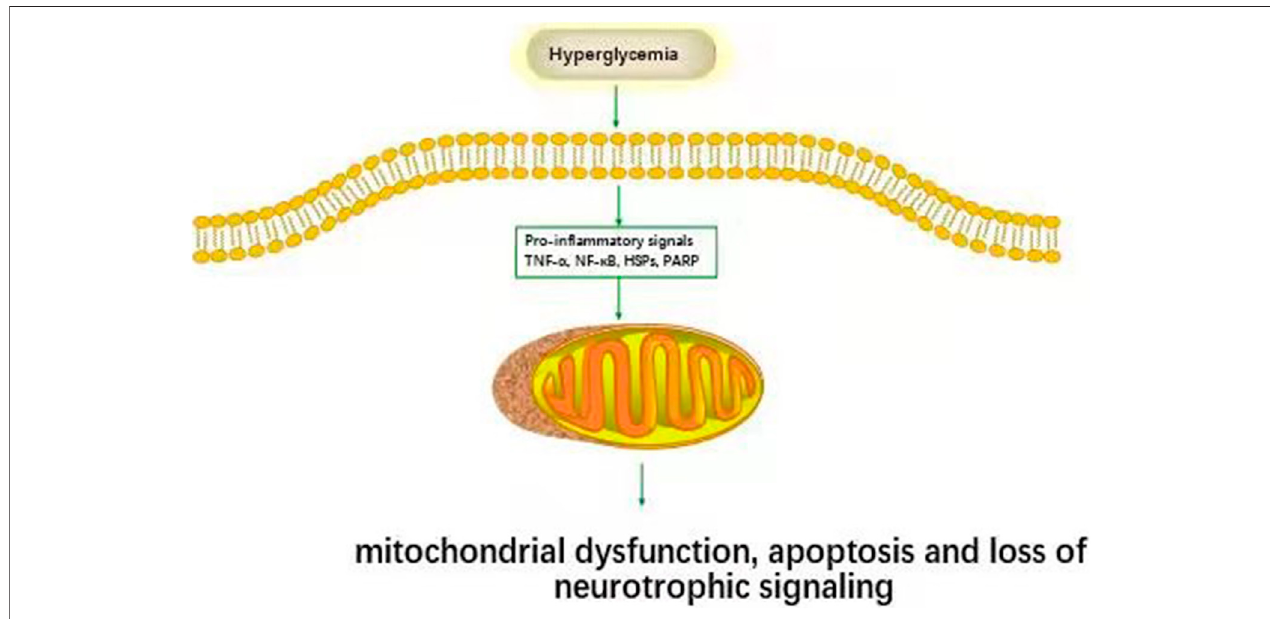
FIGURE2 | In fl ammatory pathways associated with DPN. Hyperglycemia activates in fl ammatory pathways (TNF- α , NF- κ B, HSPs, PARP et al.) and causes cell damage.